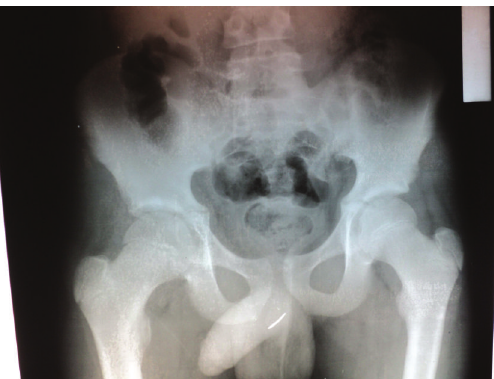
Figure 1: Posteroanterior pelvic radiogram of case 1. There is a linear, radio-opaque FB in the pelvis.